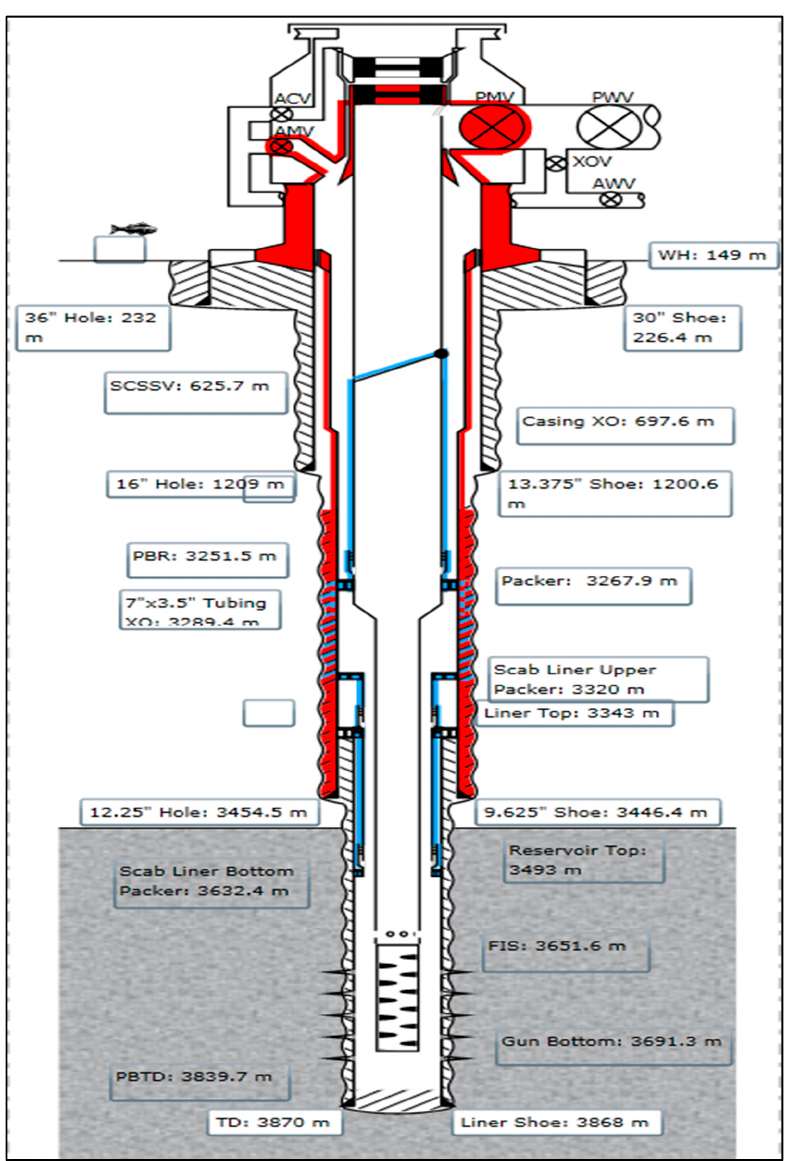
Figure 35. Well NI6 completion schematic. Figure 37. Well NI6 completion